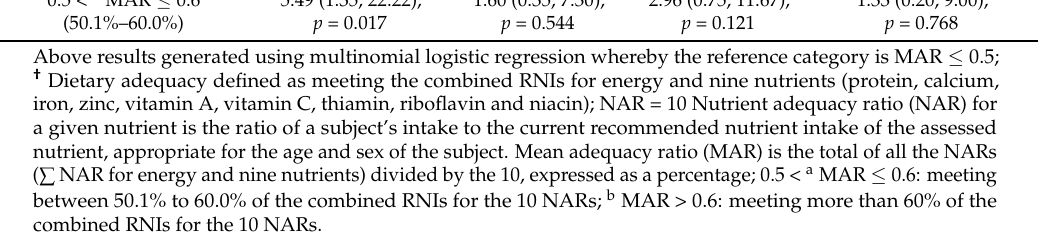
Table 4. Contributions of WHO core complementary feeding indicators to dietary intake adequacy ( N = 119) † . Minimum Minimum Minimum Consumption of Dietary Intake Adequacy Dietary Diversity Meal Frequency Acceptable Diet Based on Mean Adequacy Ratio (MAR)